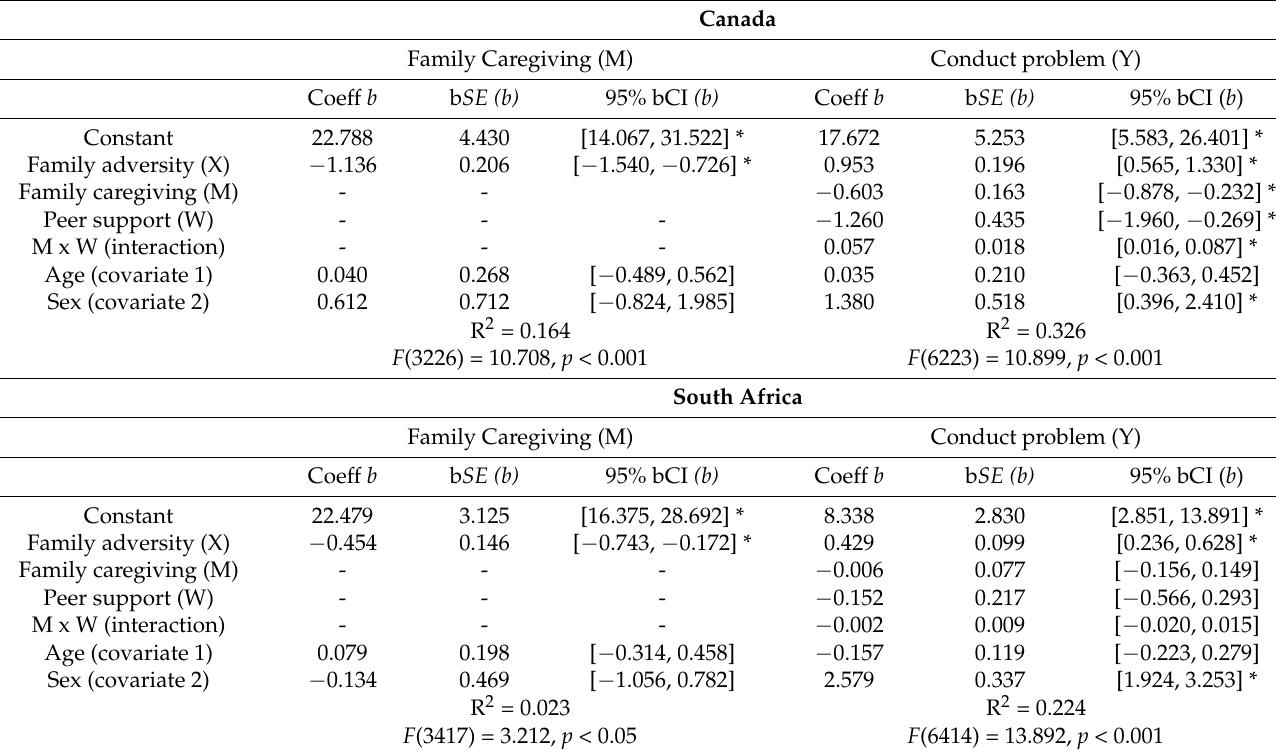
Table 3. Model coefficients for Model 1 in Figure